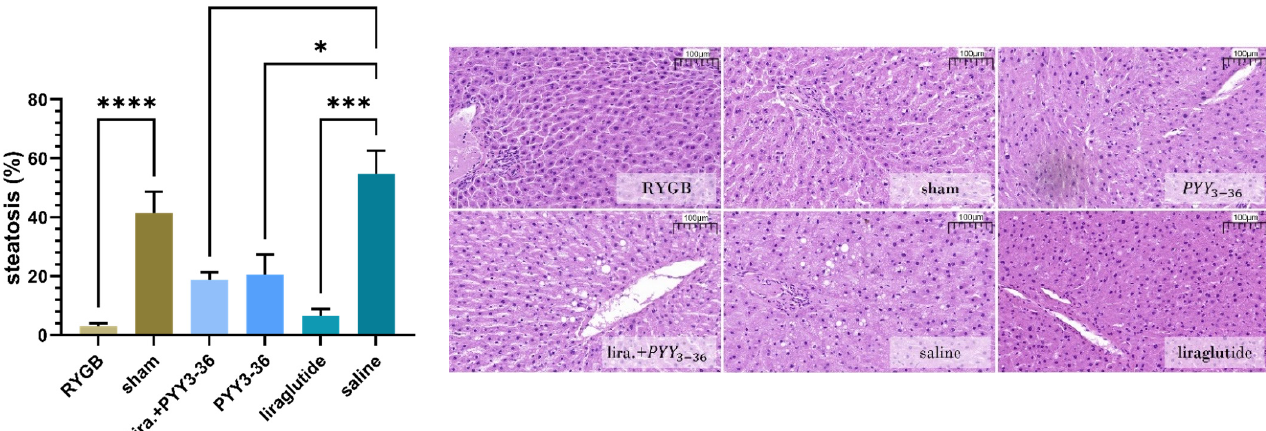
Figure 1. RYGB, PYY 3-36 and/or liraglutide significantly improved liver steatosis. Steatotic load as percent (%) of liver cells affected by macrovesicular and microvesicular fat deposits of RYGB ( n = 14), sham ( n = 13), liraglutide+PYY 3-36 ( n = 5), PYY 3-36 ( n = 5), liraglutide ( n = 5) and saline ( n = 5). Levels of significance: * p ≤ 0.05, *** p ≤ 0.001 and **** p ≤ 0.0001. Data are presented as mean ± standard error of the mean. Scale inserted on histologic slides represent 100 µ m; 20 ×